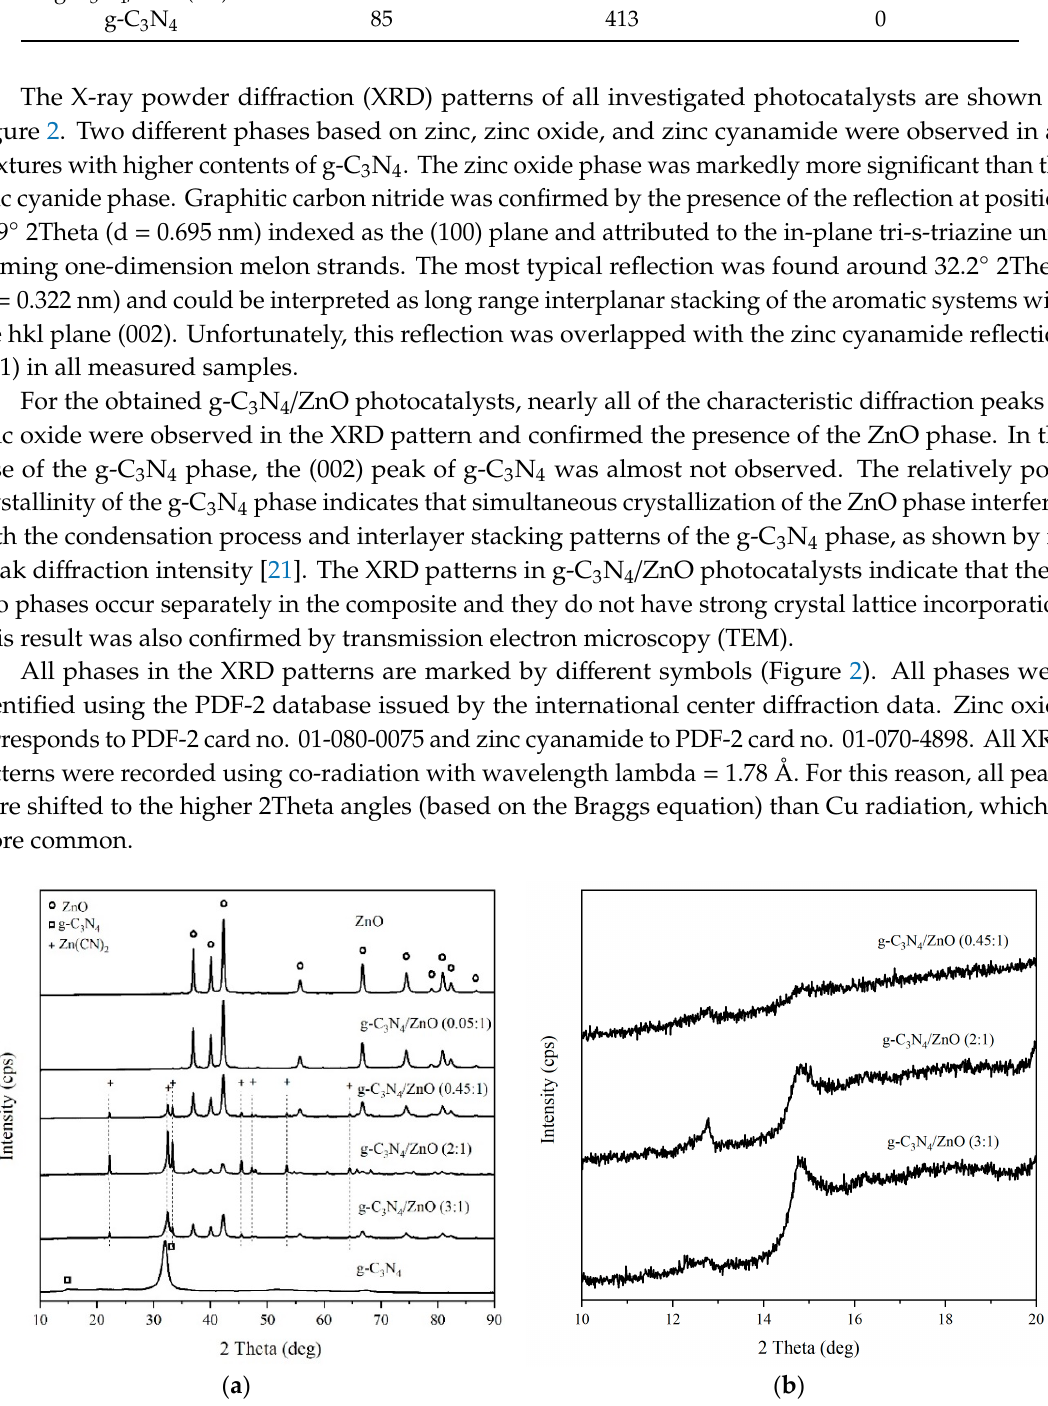
Figure 2. XRD patterns of ZnO, g-C 3 N 4 , and g-C 3 N 4 /ZnO ( a ) and XRD fragment of g-C 3 N4/ZnO (0.45:1; 2:1, and 3:1) photocatalysts ( b